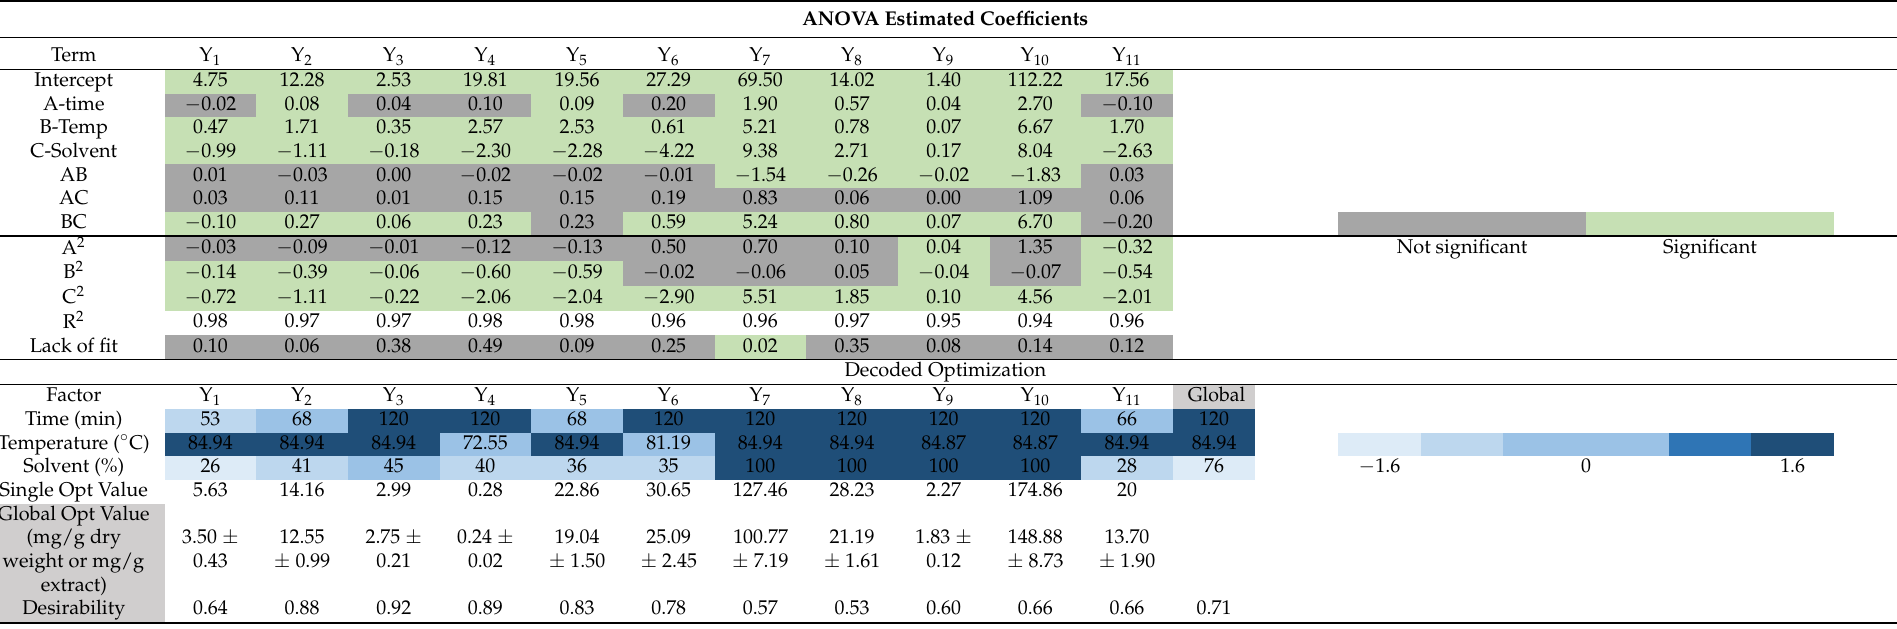
Table 2. Statistical analysis (ANOVA) of the CCCD design and decoded optimization values, including response terms for building the predictive models and optimal response values for the parametric response